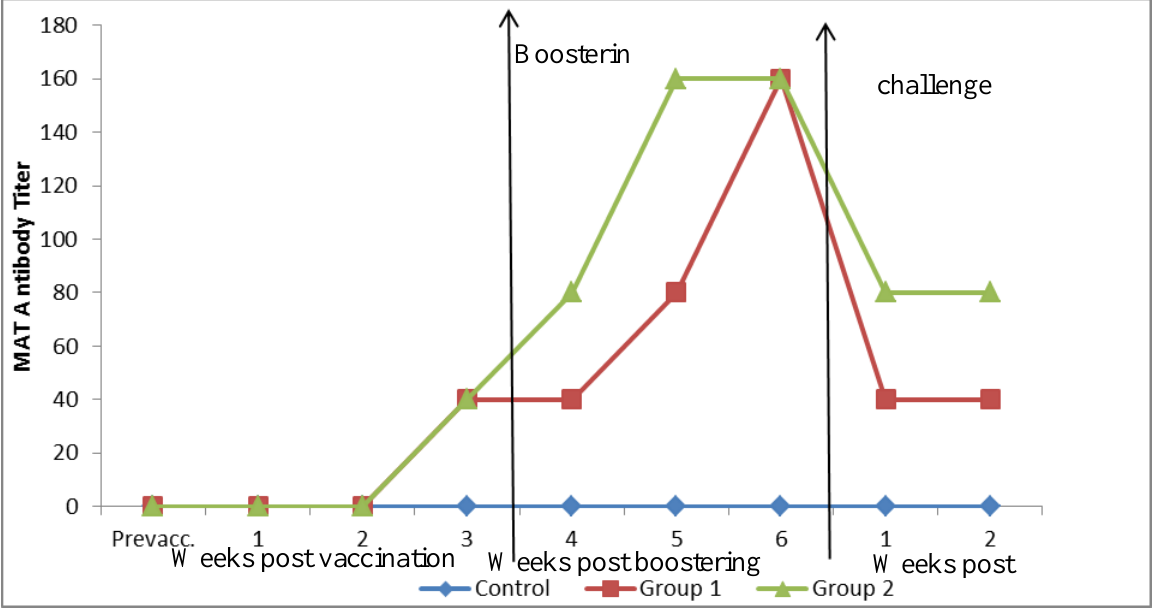
Fig.2: Microagglutination titer in sera of vaccinated turkey poults using O78 antigen and challenged with E.coli serotype O78: